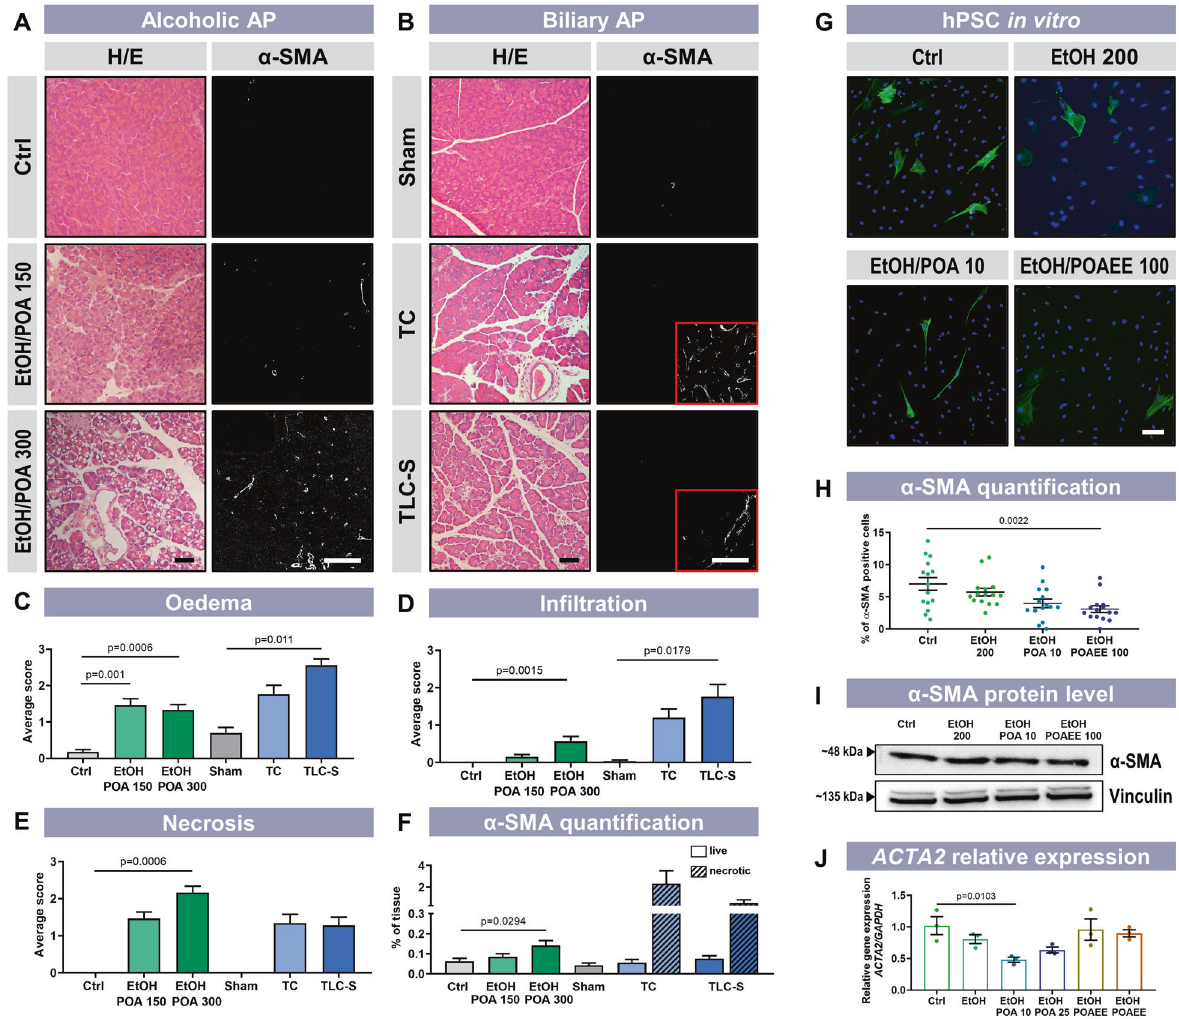
Fig. 2 Ethanol metabolites increase α -SMA expression in the alcoholic AP mouse model in vivo but not in vitro in hPSCs. A Alcoholic AP was induced by intraperitoneal injection of ethanol (1.5 g/kg) and palmitoleic acid (POA, 150 or 300 mg/kg, n = 6 for both) in the presence of PEG 200 (1 g/kg), twice at 1 h intervals. Control mice received saline injections ( n = 6). H/E staining shows an increasing severity of in fl ammation with increasing doses of POA (left panels). IHF staining shows a dose-dependent increase in α -SMA expression (presented in white) throughout pancreatic tissue (right panels). Scale bars: 50 µm. B Two models of bile acid-induced AP: taurocholate (TC)-elicited acute pancreatitis (TC-AP) was induced by retrograde pancreatic ductal injection with 1% TC (5 µl/min over 10 min by infusion pump, n = 5); taurolithocholic acid 3-sulfate (TLC-S)-elicited acute pancreatitis (TLC-S-AP) was induced by retrograde pancreatic ductal injection with 3 mM TLC-S (5 µl/min over 10 min by infusion pump, n = 5); for both models, saline injections (sham) were experimental controls ( n = 3). Although H/E staining con fi rms severe in fl ammation, α -SMA expression is limited only to necrotic areas (inserts shown in red frames) but is absent in live tissue. Scale bars: 50 µm. C – E Histological scoring of H/E staining was done on ten random fi elds of view by “ blinded ” investigators. The severity of each parameter – oedema ( C ), in fl ammatory cell in fi ltration ( D ) and acinar cell necrosis ( E ) — was scored using a 4-level grade [28, 51]. Results were presented as mean ± SEM. F α -SMA expression was quanti fi ed as a ratio of α -SMA-positive area to total tissue area (QuPath Software) [52]. Calculations were carried out in ten random fi elds of view by “ blinded ” investigators. Where applicable, live and necrotic areas were identi fi ed in transmitted light images. Results were presented as mean ± SEM. Statistical signi fi cance was calculated using Welch ’ s ANOVA with Games-Howell ’ s post hoc test (alcoholic AP) and Kruskal – Wallis and Dunn ’ s post hoc test (biliary AP and in fi ltration in alcoholic AP). G Activation of human PSCs was assessed after incubation with EtOH 200 mM, EtOH/POA 10 mM/10 µM or EtOH/POAEE 100 mM/100 µM for 24 h. The expression of α -SMA (green) is an indicator of the activated phenotype. Cell nuclei are shown in blue. Scale bar: 100 µm. H Calculated proportion of α -SMA-positive cells (±SEM) in immunostaining presented in G. Cells were counted in fi ve random fi elds of view for each of three biological replicates. Individual values are presented as dots. I Representative Western blot for α -SMA in hPSC after incubation with EtOH 200 mM, EtOH/POA 10 mM/10 µM or EtOH/POAEE 100 mM/100 µM for 24 h. Vinculin was used as a loading control. J Relative gene expression of ACTA2 (±SEM) in hPSC after incubation with given concentrations of ethanol, POA or POAEE (EtOH 200 mM; EtOH/POA 10 mM/10 µM; EtOH/POAEE 100 mM/100 µM) for 24 h. Expression was normalised to glyceraldehyde-3-phosphate dehydrogenase ( GAPDH; N = 3). Statistical signi fi cance was calculated using the one-way ANOVA test followed by a post hoc analysis with the Dunnett